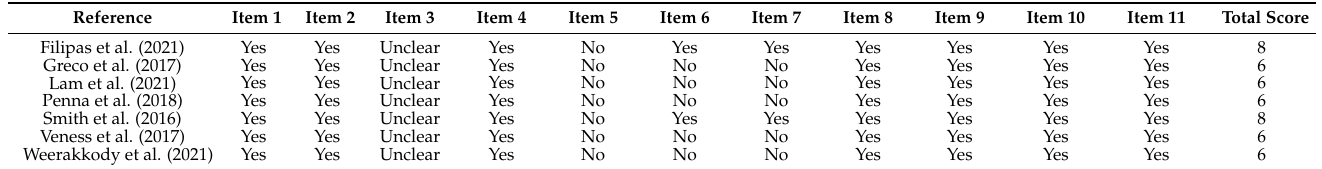
Table 3. Results from the methodological quality assessment using the PEDro checklist.